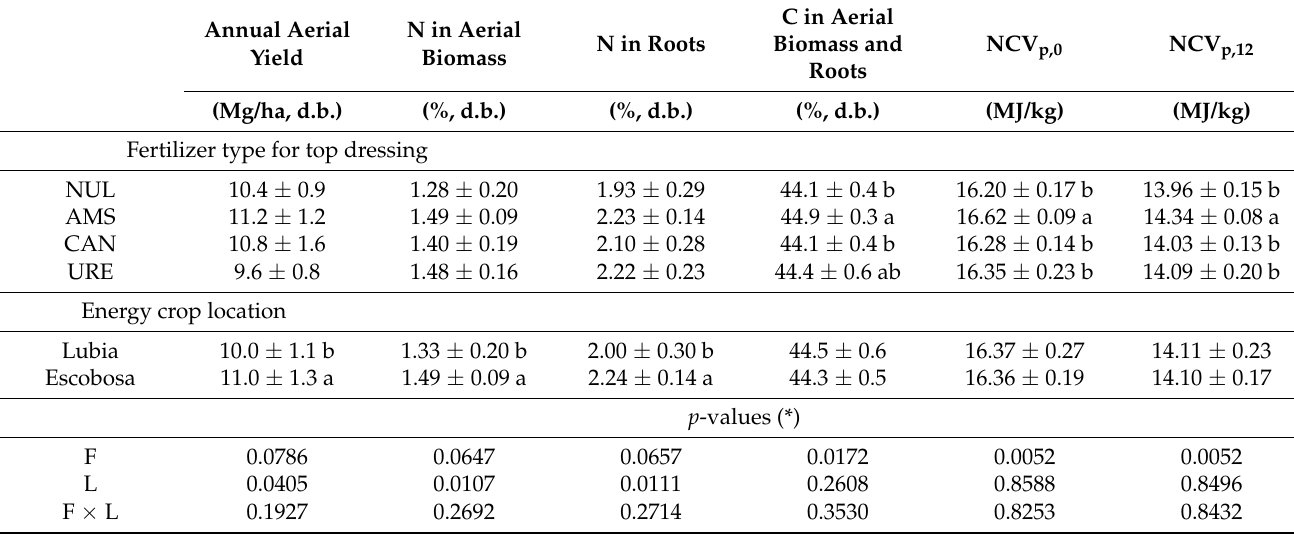
Table 5. Calorific value, biomass yield and composition (means ± standard deviations) depending on the N fertilizer type used for top dressing and location. C in Aerial Annual Aerial N in Aerial N in Roots Biomass and NCV p,0 NCV p,12 Yield Biomass Roots (Mg/ha, d.b.) (%, d.b.) (%, d.b.) (%, d.b.) (MJ/kg)